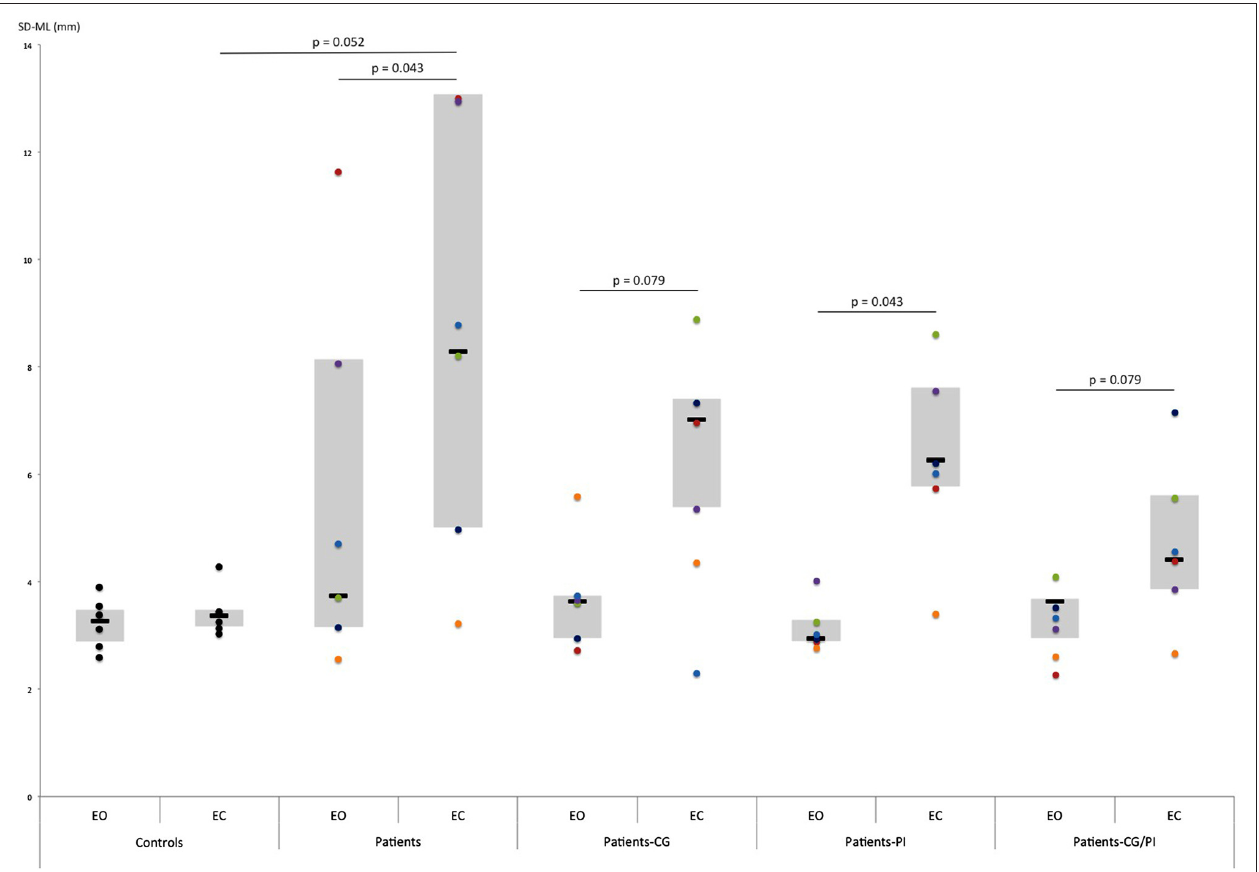
FIGURE 6 | Comparison of SD-ML (standard deviation of mediolateral COP displacement: mm) obtained by hEDS patients and controls, with eyes open (EO) and eyes closed (EC) depending on the somatosensory orthoses worn (CG, compression garments; PI, proprioceptive insoles; CG-PI, both somatosensory orthoses). Box plots represent median and quartiles, and dots represent performance of each participant as follows: controls: black; patient 1: red; patient 2: green; patient 3: purple; patient 4: light blue; patient 5: orange; patient 6: dark